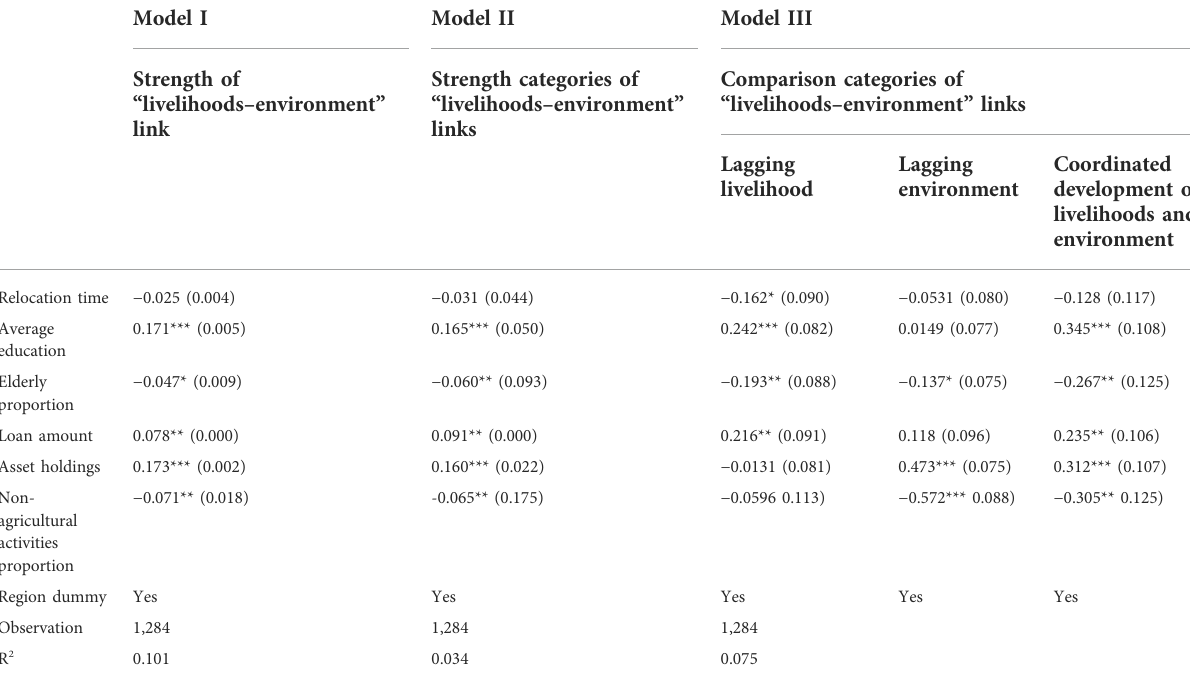
TABLE 8 Household factors associated with “ livelihoods – environment ”